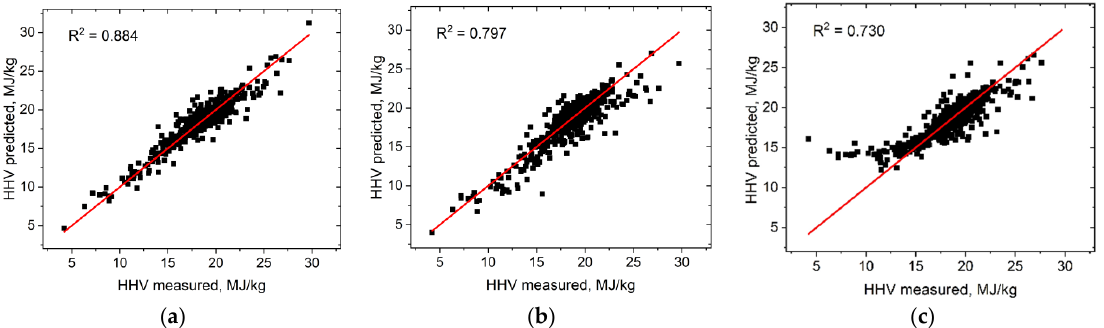
Figure 9. Comparison of the prediction achieved using: ( a ) ANN; ( b ) empirical Equation (10); ( c ) empirical Equation (11).